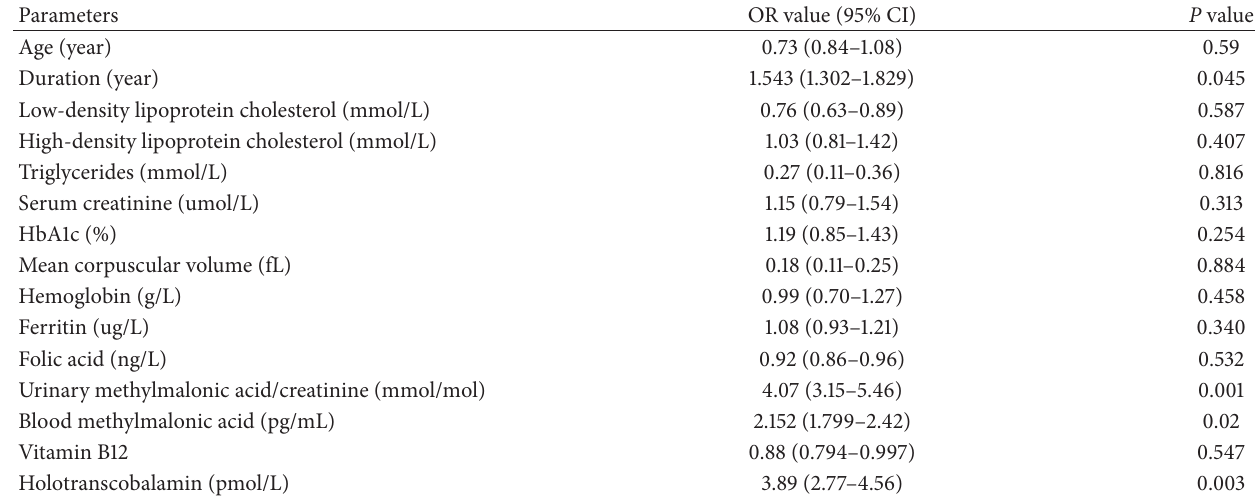
Table 2: Logistic analysis of influencing factors of diabetic